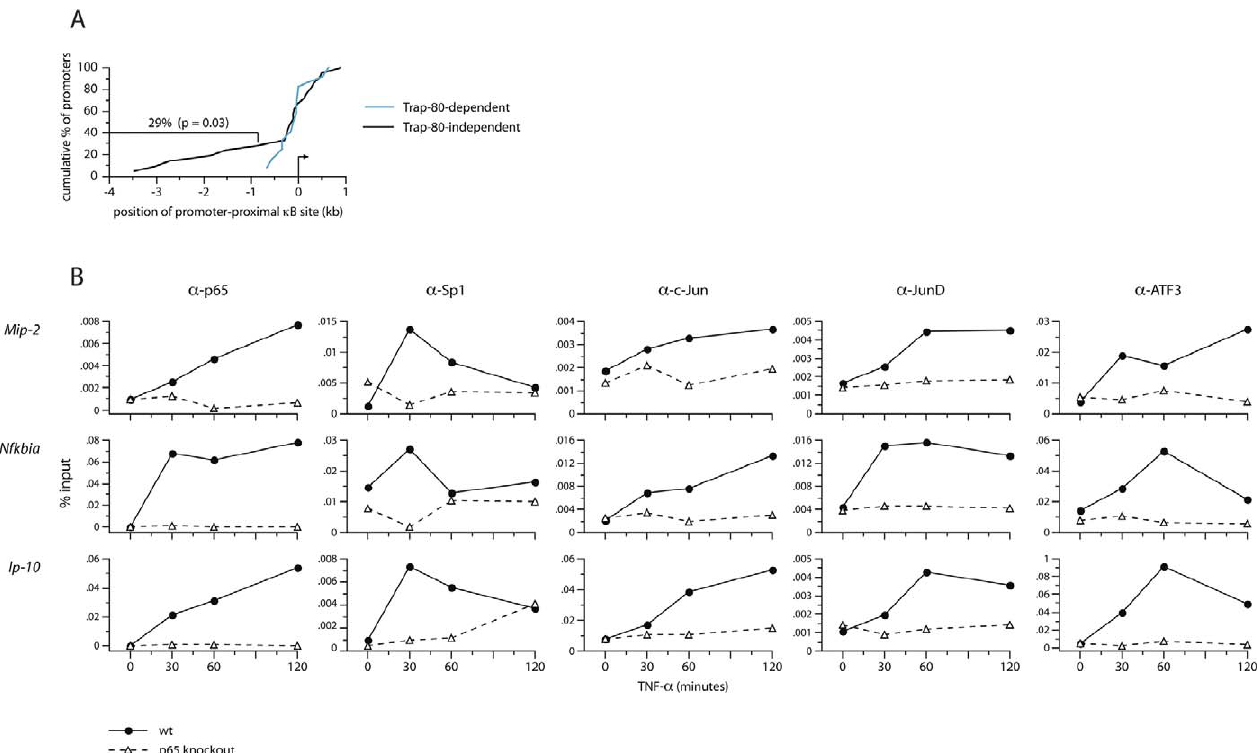
Figure 6. p65 Is Required for Promoter Occupancy by Secondary Transcription Factors (A) Positions of promoter-proximal NF- j B binding motifs relative to the transcriptional start site. Cumulative percentage of promoters in which the closest conserved NF- j B binding motif lies within the indicated distance to the TSS. Promoters analysed are those of the top 30 Trap-80–dependent and 30 Trap-80–independent genes, from amongst the 200 most induced by TNF- a . (B) Recruitment of p65 and secondary transcription factors to the Mip-2 , Nfkbia, and Ip-10 promoters in wild-type and p65-knockout fibroblasts. ChIP using antibodies against p65, Sp1, c-Jun, JunD, or ATF-3, after stimulation with TNF- a . The results presented here are representative of two to three